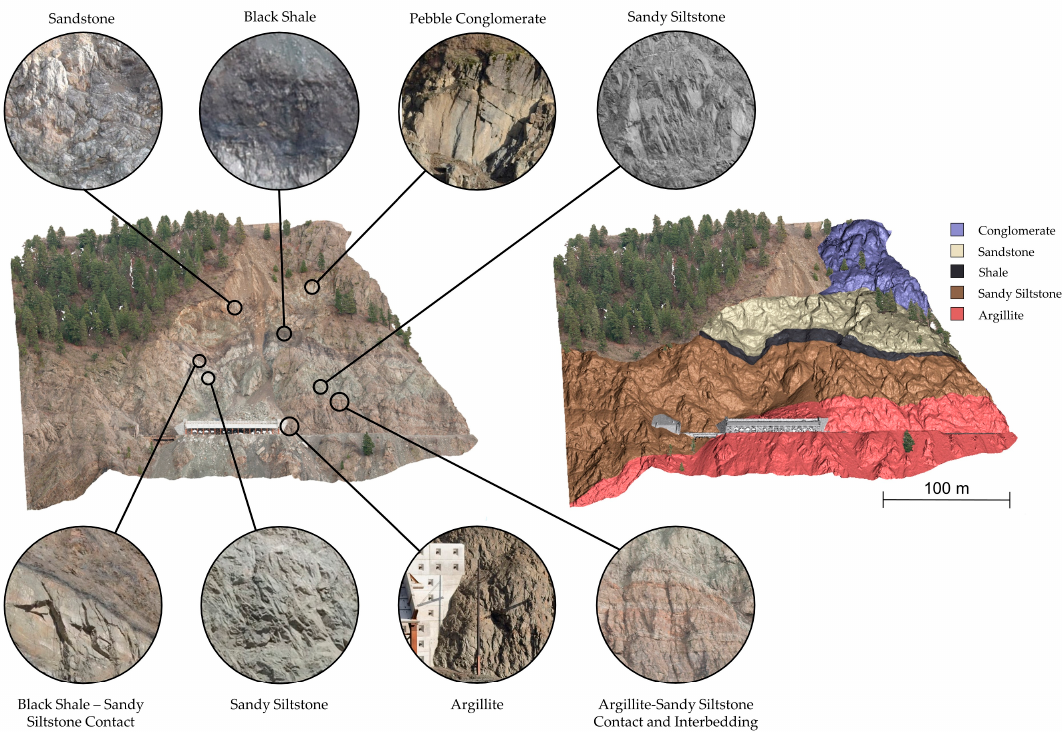
Figure 3. Overview of the five lithological units of the CN Ashcroft Mile 109.4, depicted in a photogrammetry point cloud, high-resolution photographs, and a mapped bedrock model. The photogrammetry point cloud was generated from a series of photographs taken from a helicopter. Further information involving the construction of the photogrammetry dataset and subsequent geological mapping is presented in Sections 2.1.3 and 2.2.7, respectively.